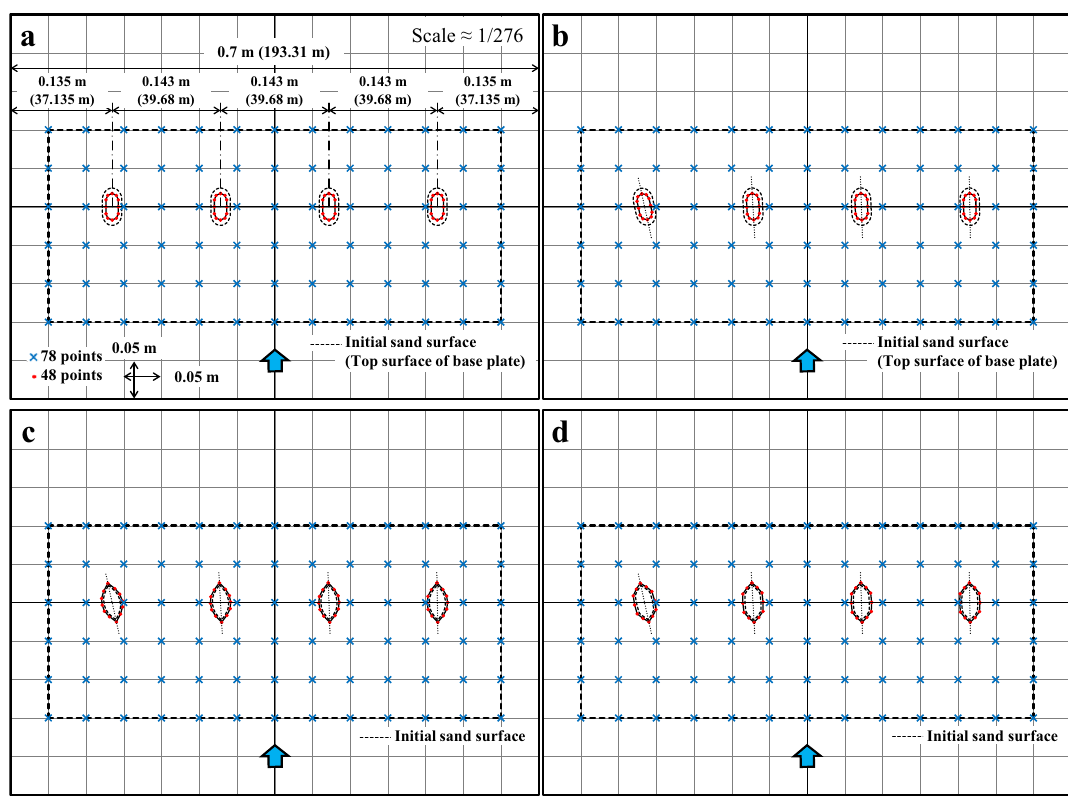
Figure 6. Measurement points for sand layer thickness and scouring around piers. ( a ) current; ( b ) current (skewed); ( c ) old (spindle type); ( d ) old (current